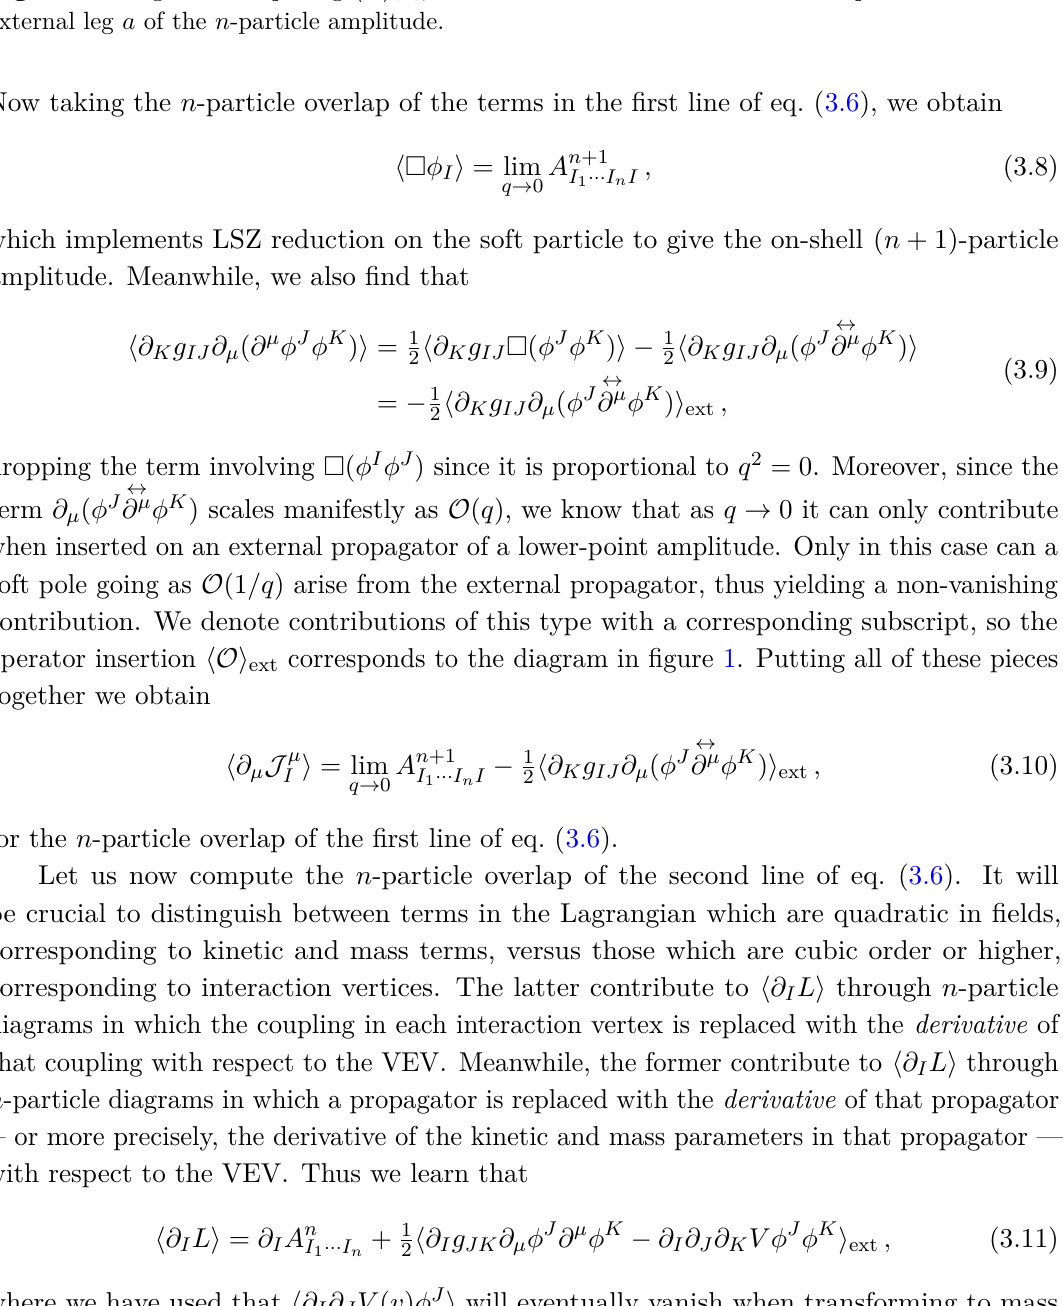
Figure 1 . Diagrams computing hOi ext , which sums over the insertion of an operator O on each external leg a of the n -particle